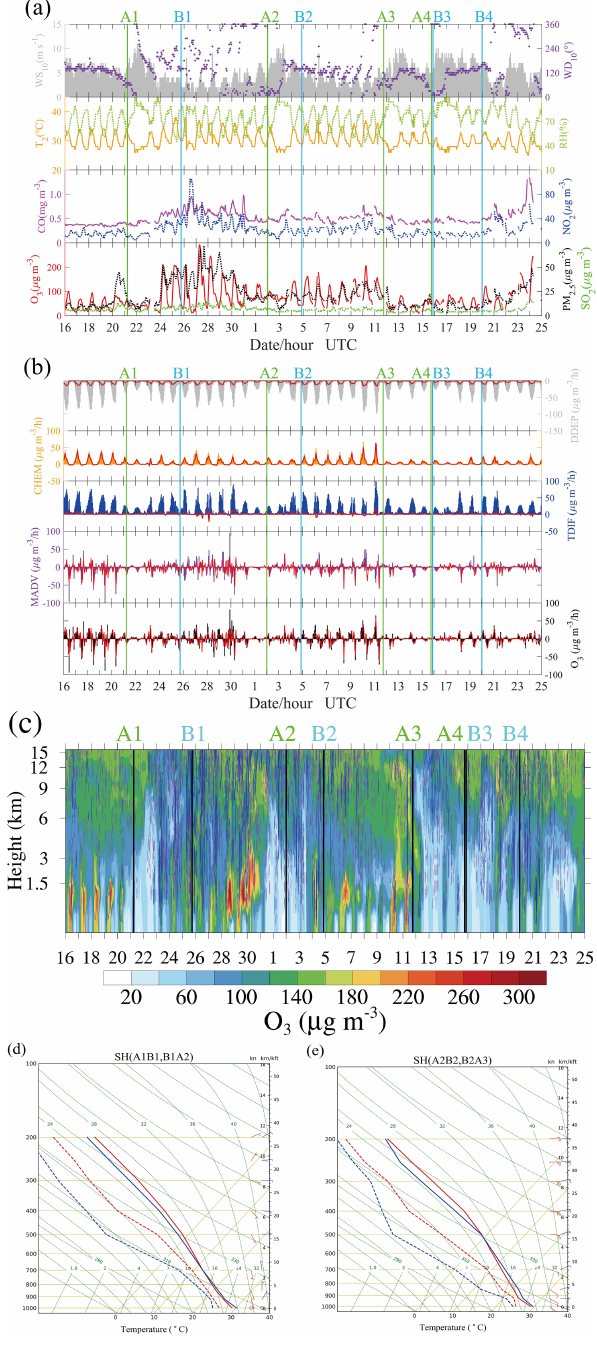
Figure 6. (a) Time series of air pollutants (O 3 , PM 2 . 5 , SO 2 , CO and NO 2 ) and meteorological factors ( T 2 , RH, WS 10 and WD 10 ) in Shanghai. (b) Individual processes contributing to net O 3 density at Shanghai. O 3 is the net increase, MADV is the sum of horizontal advection (HADV) and vertical advection (ZADV), TDIF is the sum of horizontal diffusion (HDIF) and vertical diffusion (VDIF), CHEM is the chemical reaction process, and DDEP is the dry deposition process. The color histograms indicate the results for the layer near the surface, while the solid red lines indicate the average results for all layers below 1500m. (c) Temporal-vertical distribution of O 3 with vertical wind velocity over Shanghai. The dotted purple line and solid blue line indicate the negative wind speeds (downward airflows) and positive wind speeds (upward airflows), respectively. (d) The skew-T log-P diagram for Shanghai. The average results of period A1B1 and B1A2 are shown in red and blue, respectively. (e) Same as (d) but for the average results of period A2B2 and B2A3.